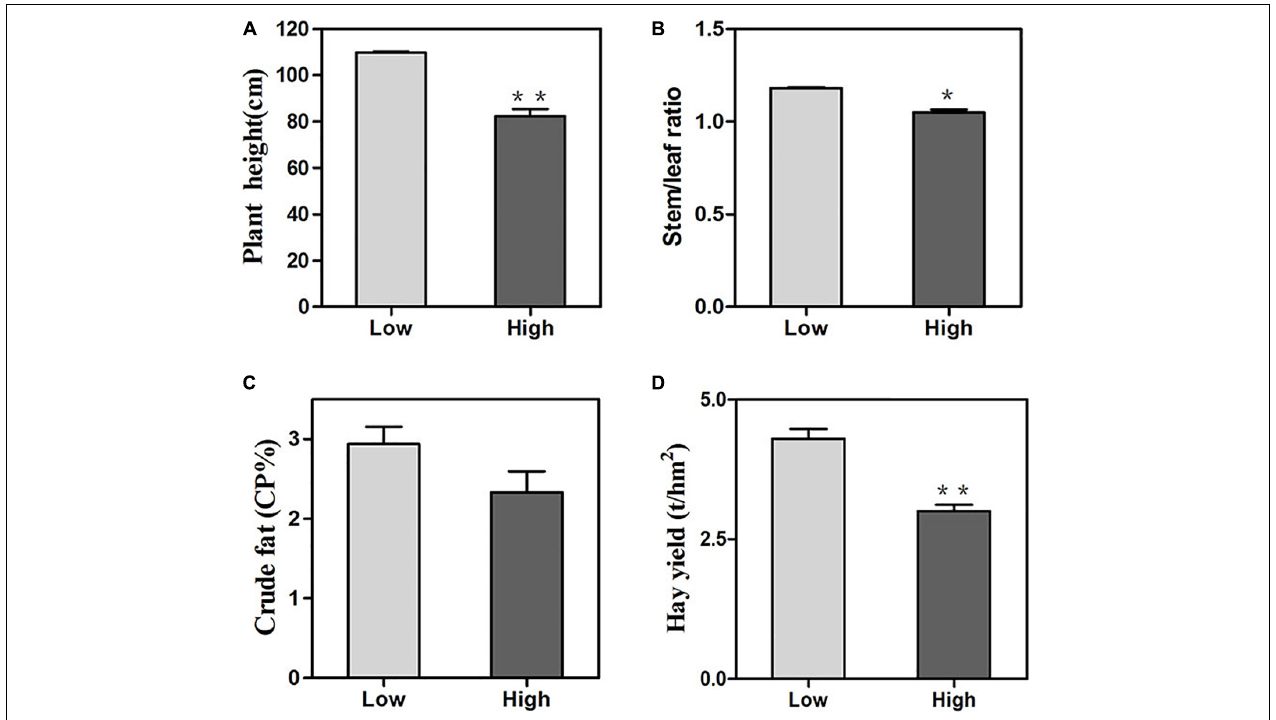
FIGURE 2 | Agronomic trait changes of oats at low and high altitudes. (A) plant height, (B) crude protein, (C) crude fat, (D) hay yield. Means were compared using one-way ANOVA. All parameters were shown as the mean ± SE. Significant differences from low altitude were denoted by one or two asterisks corresponding to P < 0.05 and P < 0.01, respectively by the Student’s t -test.